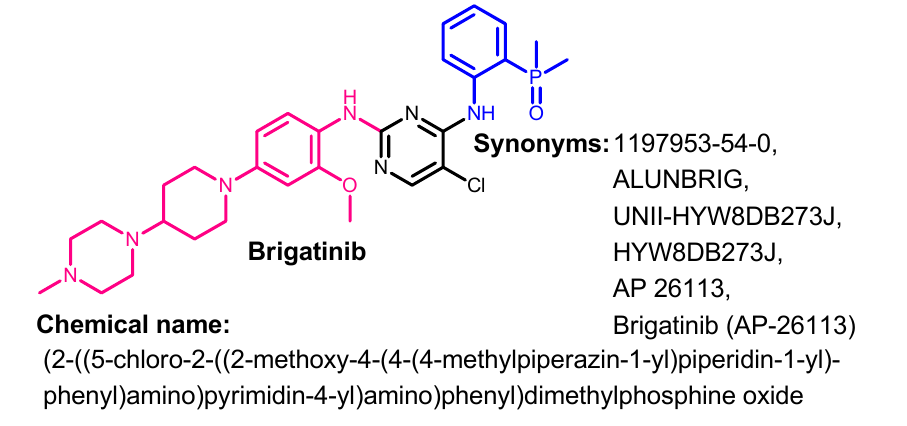
N Figure 16. Chemical structure/name/synonyms of brigatinib.